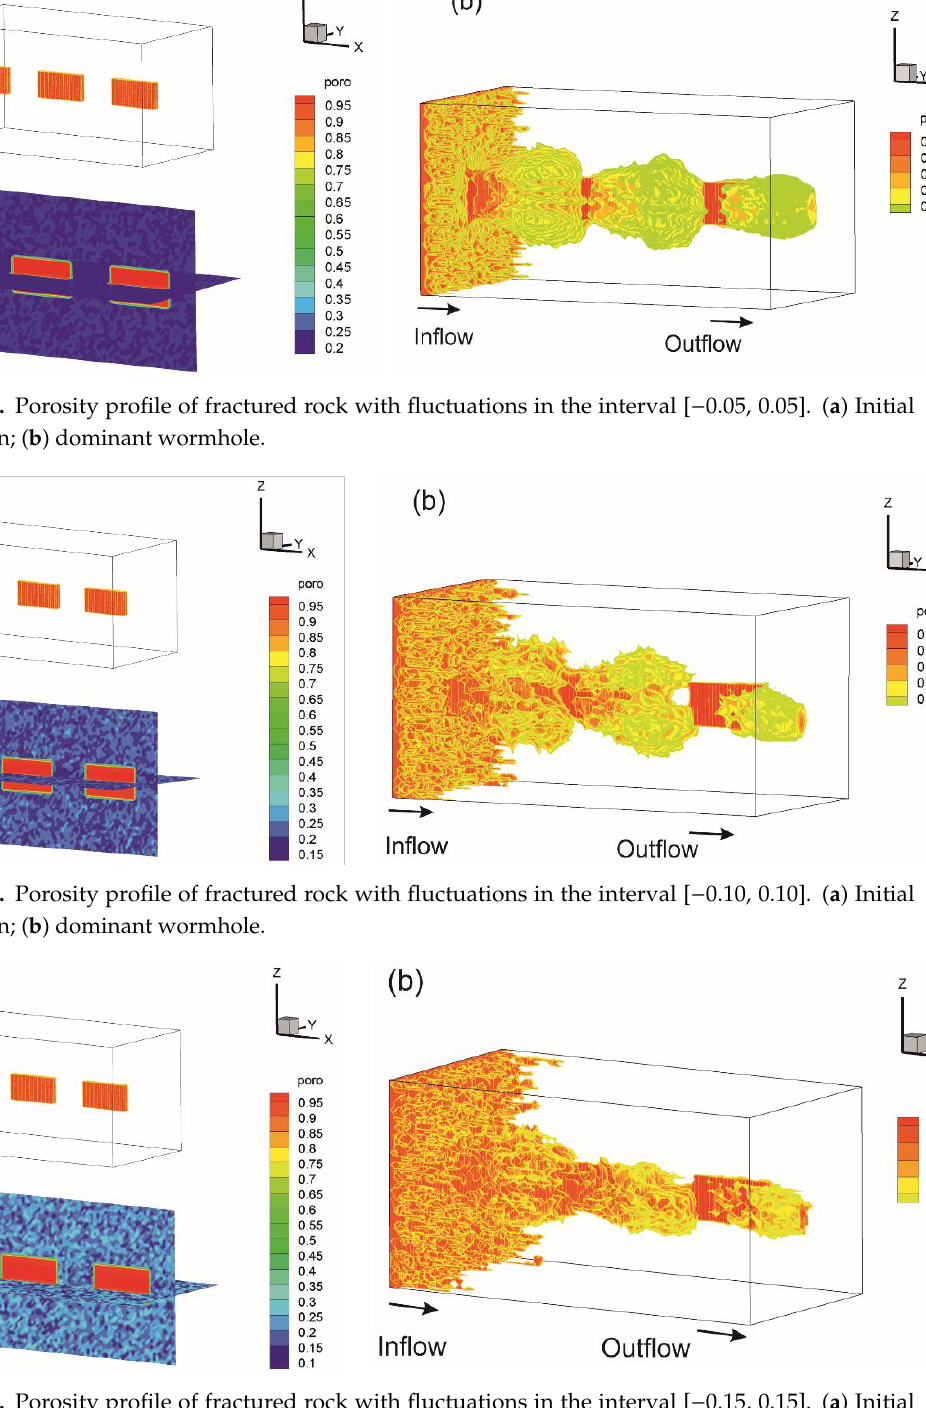
Figure 7. Porosity profile of fractured rock with fluctuations in the interval [−0.15, 0.15]. ( a ) Initial condition; ( b ) dominant wormhole.